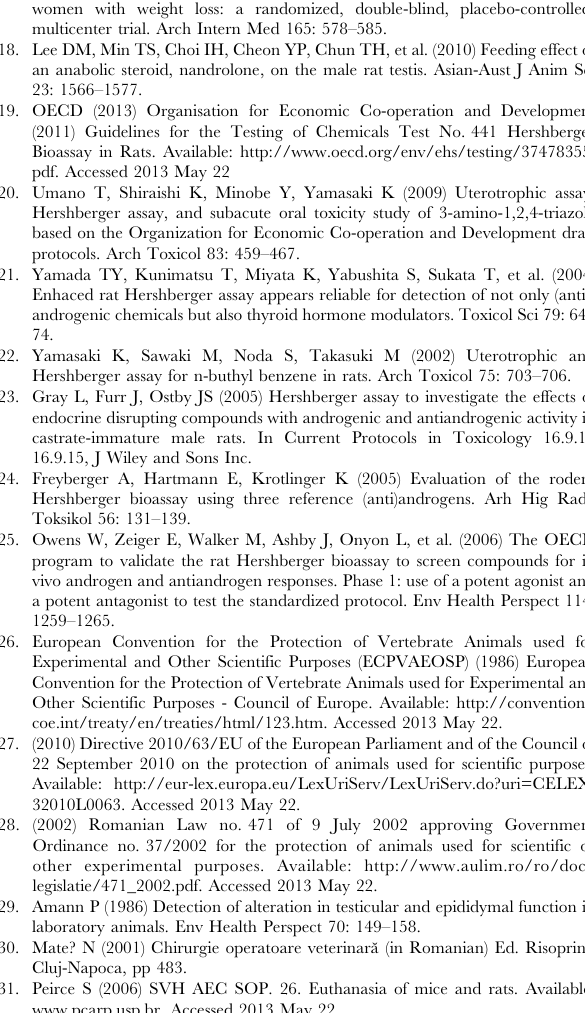
Figure S5, Mean weight of levator ani-bulbocavernosus muscle (mg). Figure S6, Mean weight of Cowpers glands (mg). Figure S7, Mean weight of glans penis